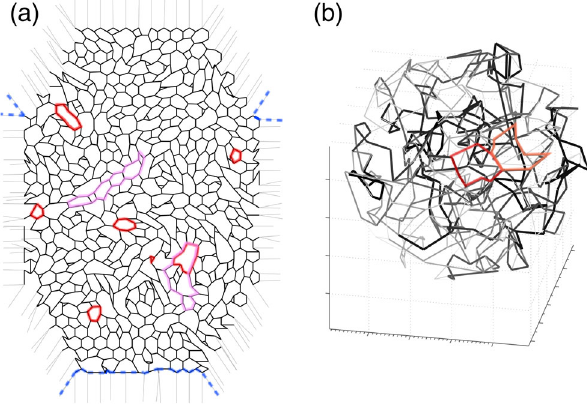
FIG. 4. (a) Graph embedded on a two-holed torus, schematic. Periodic boundary conditions connect opposite sides of the octagon. Highlighted are some example tiling basis vectors from a fundamental cycle basis (magenta) and from the minimum weight basis (red). The blue curve highlights one of the 2 g ¼ 4 vectors in the minimal basis corresponding to the generators of the fundamental group of the two-holed torus. (b) A 3D graph with an unknown embedding. Identification of tiling versus generator basis vectors is not straightforward anymore. High- lighted with red and orange are two vectors in the minimum weight basis that share an